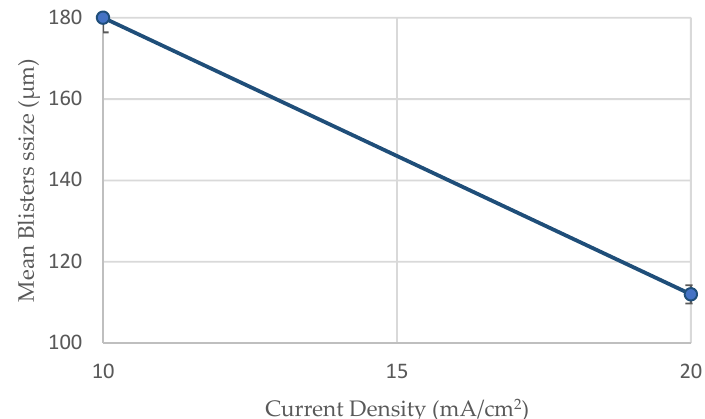
Figure 14. Mean size of blisters developed under the in situ hydrogen cathodic charging process (10 and 20 mA / cm 2 ) and slow strain rate bending loading.